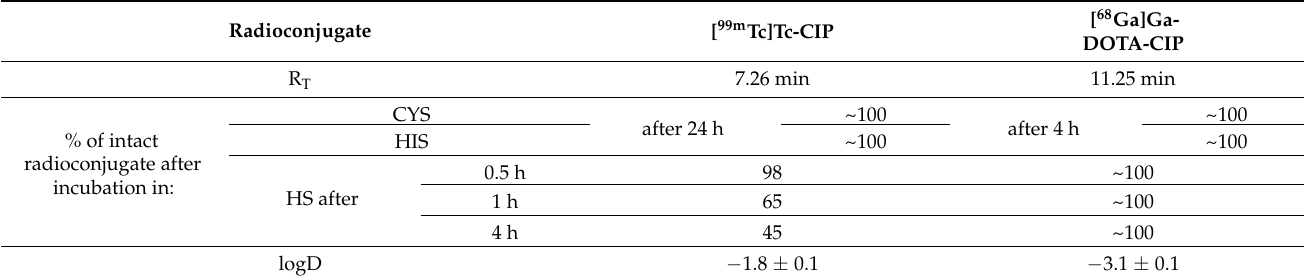
Table 1. Results of physicochemical studies of [ 99m Tc]Tc-CIP and 68 Ga]Ga-DOTA-CIP radioconjugates.